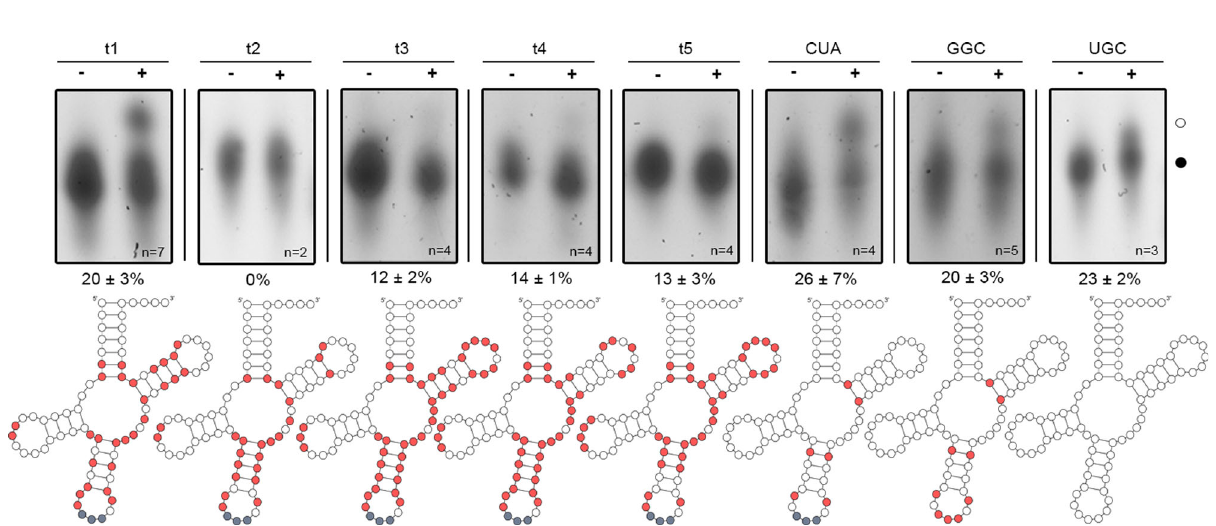
Fig. 2 Designed nonsense suppressor tRNAs t1, t3 – t5 are substrates of AlaRS. Aminoacylation with Ala catalyzed by E. coli AlaRS ( + ) compared to nonaminoacylated in vitro transcribed tRNAs ( − ). Aminoacyl-tRNAs ( ○ ) migrate slower compared to non-acylated tRNAs ( ● ). Aminoacylation levels are means ± s.d. ( n , biologically independent experiments). In the schematic, nucleotides varied in each tRNA design, native tRNA Ala GGC, and UAG-decoding tRNA Ala CUA compared to the native tRNA Ala UGC are highlighted in red; the anticodon CUA (gray) decoding UAG stop codon is the same for all engineered tRNAs. All replicates are provided as a Source data fi